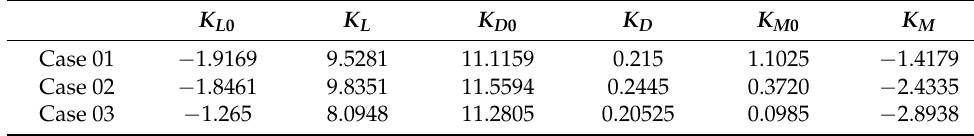
Table 3. Values of hydrodynamic parameters.